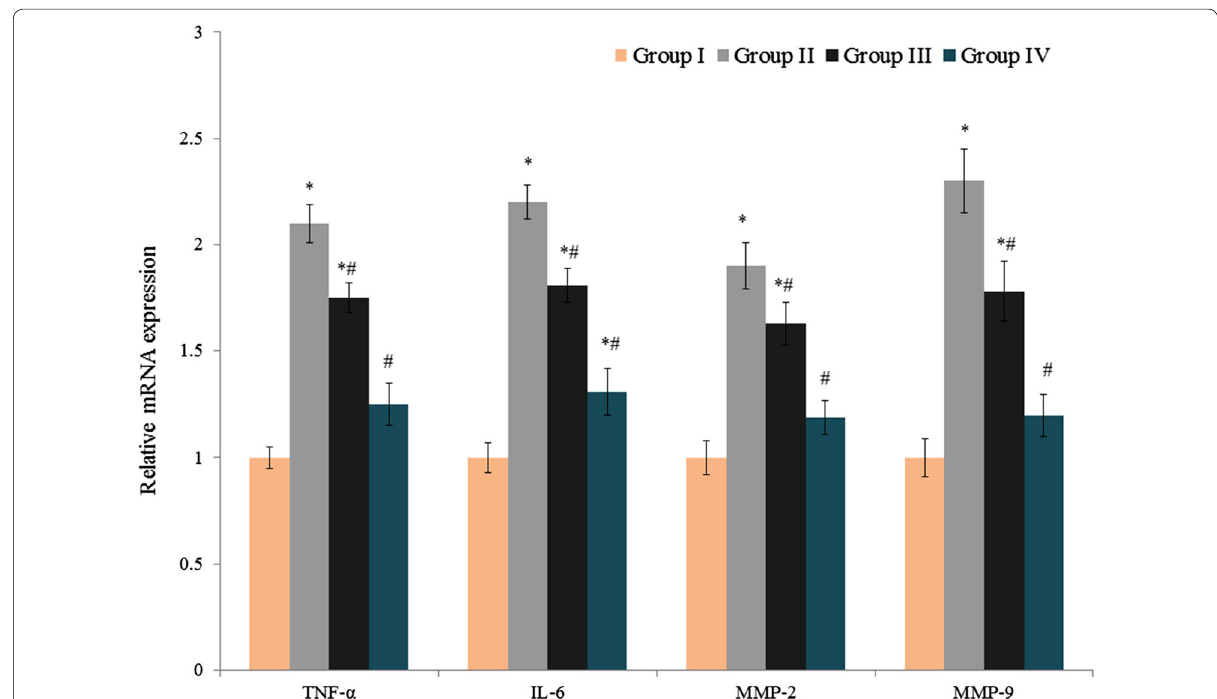
Fig. 3 Effect of atorvastatin and amygdalin on the mRNA expression of TNF-α, IL-6, MMP-2 and MMP-9 in the transplant salvage tissue of Sprague-Dawley rats with experimentally induced endometriosis. Values are expressed as fold changes. * P < 0.05 vs. group I (sham-operated rats) and # P < 0.05 vs. group II (non-treated endometriosis control rats)